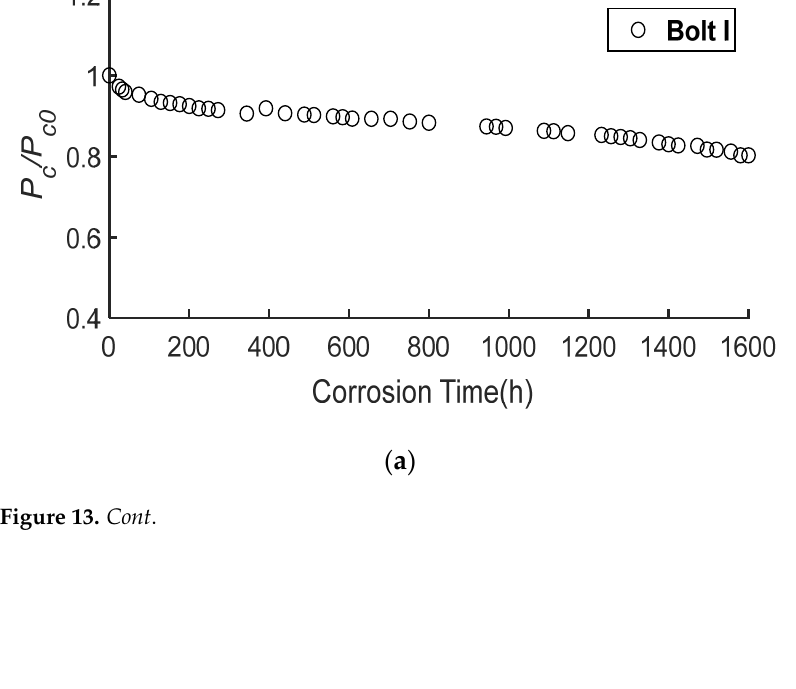
( b ) ( c ) Figure 13. Preload ( P c / P c 0 ) versus corrosion time. ( a ) Bolt I; ( b ) Bolt II; ( c ) Bolt III. Table 6. Details of specimens in test. Specimens